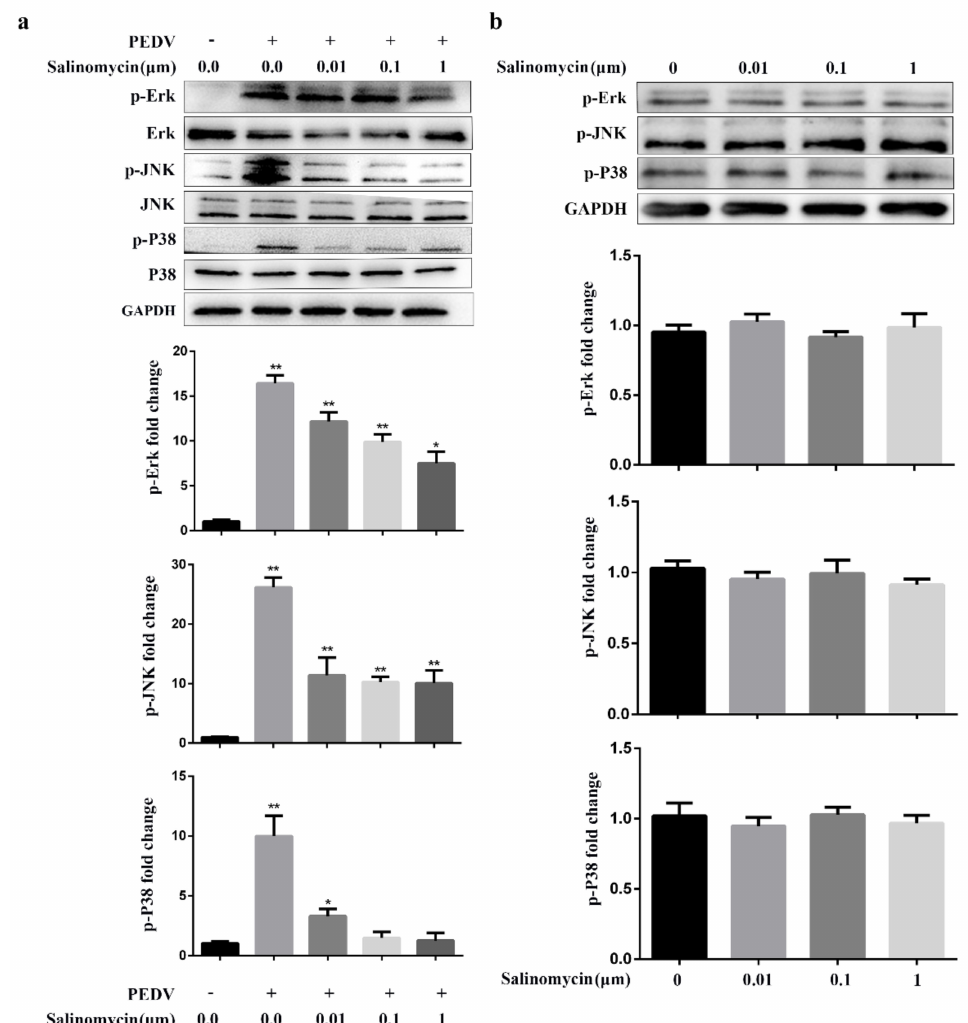
Figure 5. Effect of salinomycin on MAPK signaling in response to PEDV infection. ( a ) Serum starved Vero cells pretreated with salinomycin at the indicated concentrations for 1 h, respectively, then infected with PEDV in the presence of salinomycin for 24 hpi. The cell lysate was prepared and subjected to western blotting analysis. ( b ) Serum starved Vero cells were exposed to salinomycin at the indicated concentrations for 24 h. Cell lysate was prepared and subjected to western blotting analysis. The band intensity was analyzed with software image J. These results represented three independent experiments and data presented as means ± SD. * p < 0.05. ** p <